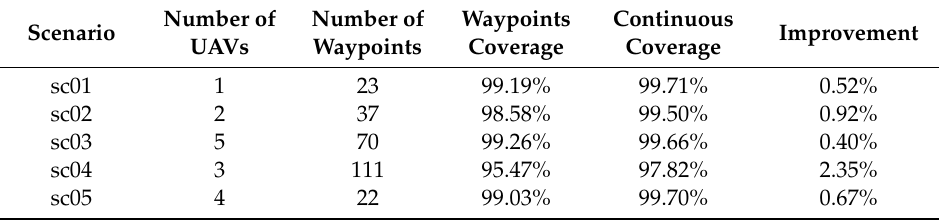
Table 11. Comparison of the original and continuous monitoring.